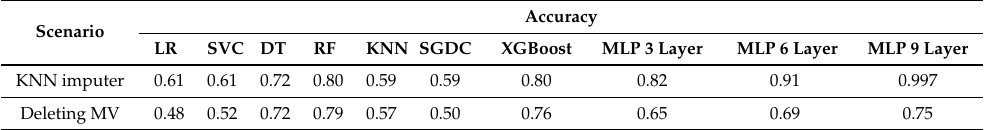
Table 9. Accuracy of all models using KNN imputer.